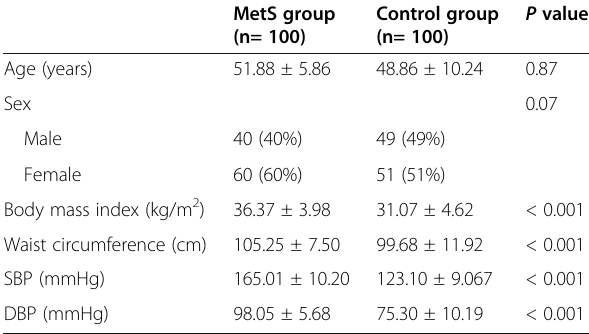
Table 2 Baseline data of enrolled groups